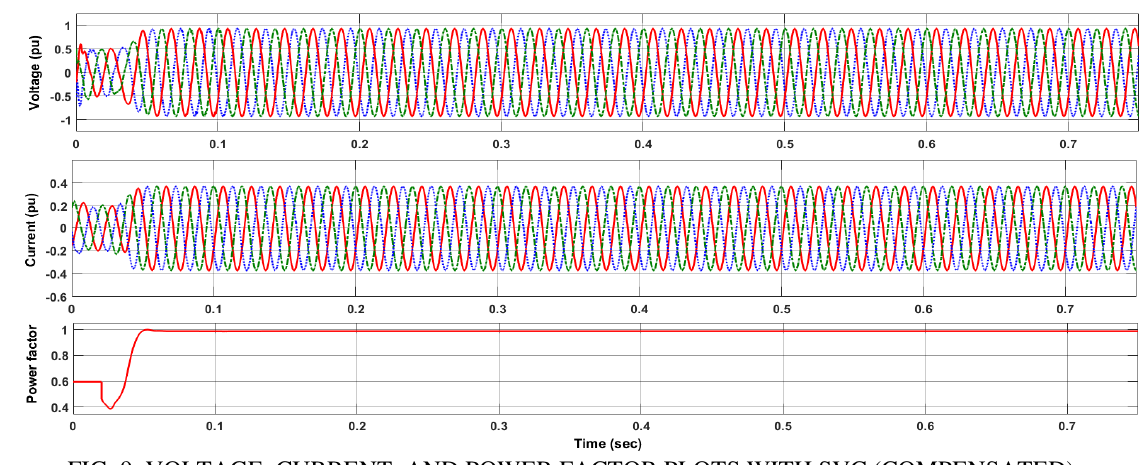
FIG. 9. VOLTAGE, CURRENT, AND POWER FACTOR PLOTS WITH SVC